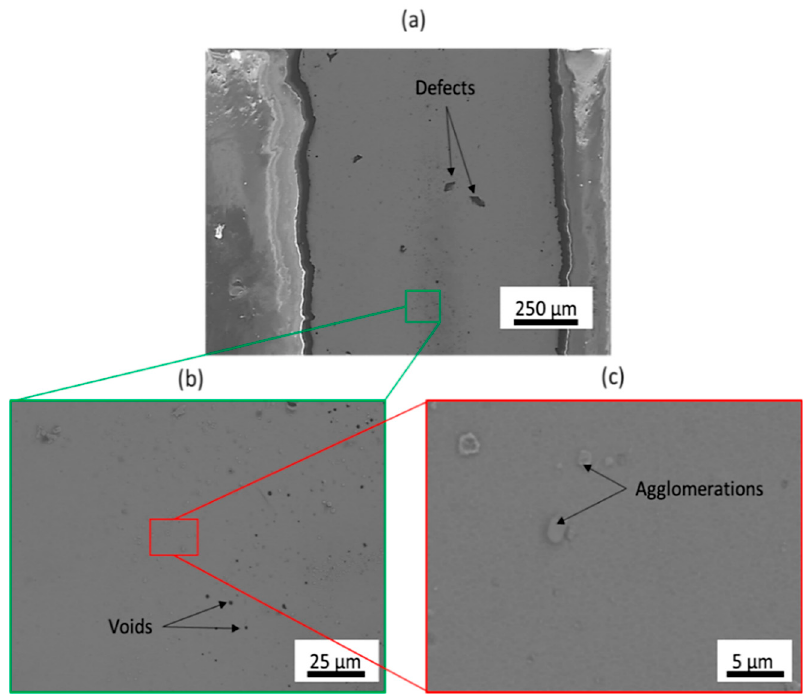
Figure 5. SEM images of the printed wire at the end of the sintering process. at three different magnification; ( a ): x100, ( b ): x1000, ( c ): x5000.